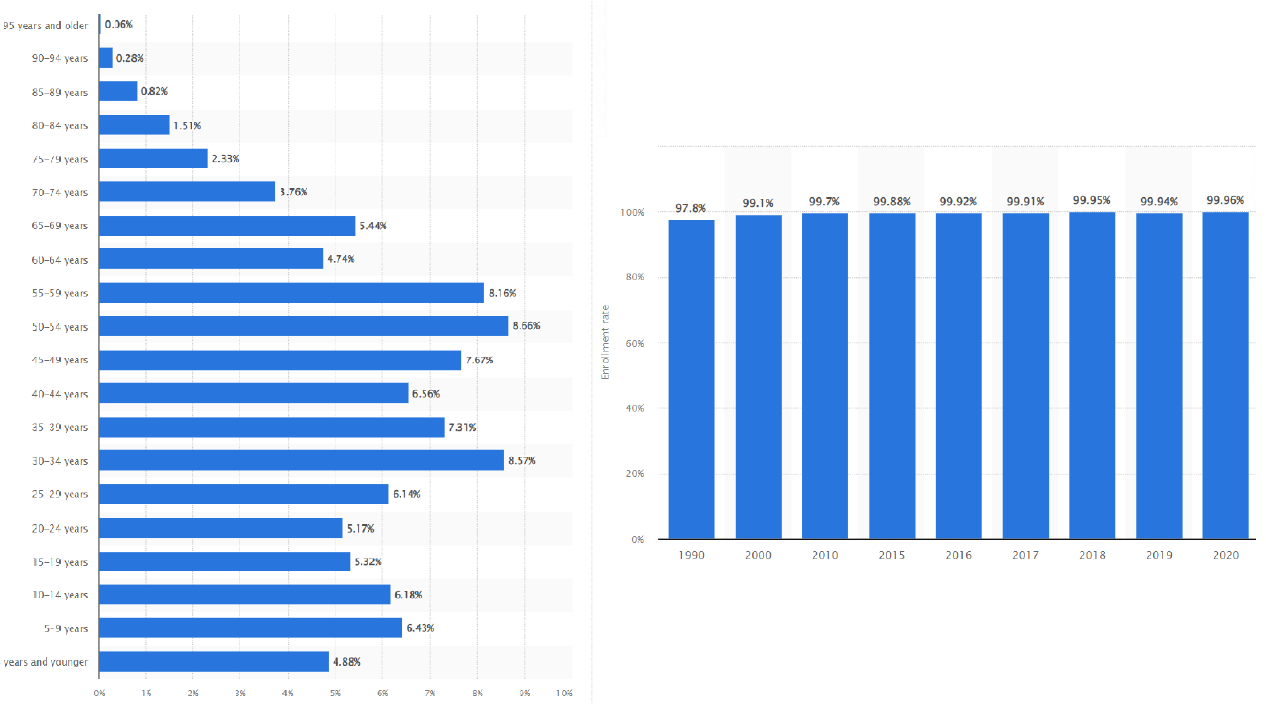
Figure 1. Population distribution and education level in China.